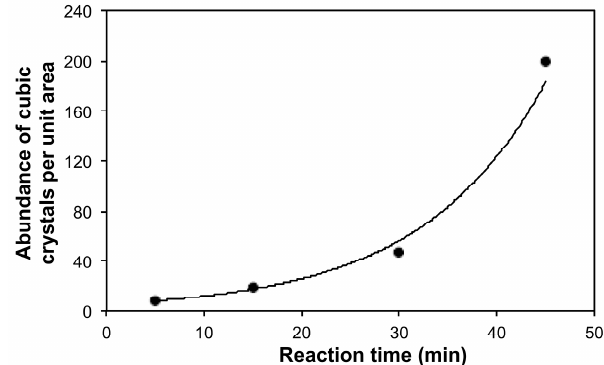
Figure 3. Plot of the abundance of cubic crystal morphology per unit area (25 µ m 2 ) as determined by SEM) in the Cu-SWCNT composites prepared by electroless deposition as a function of reaction time ( R 2 =